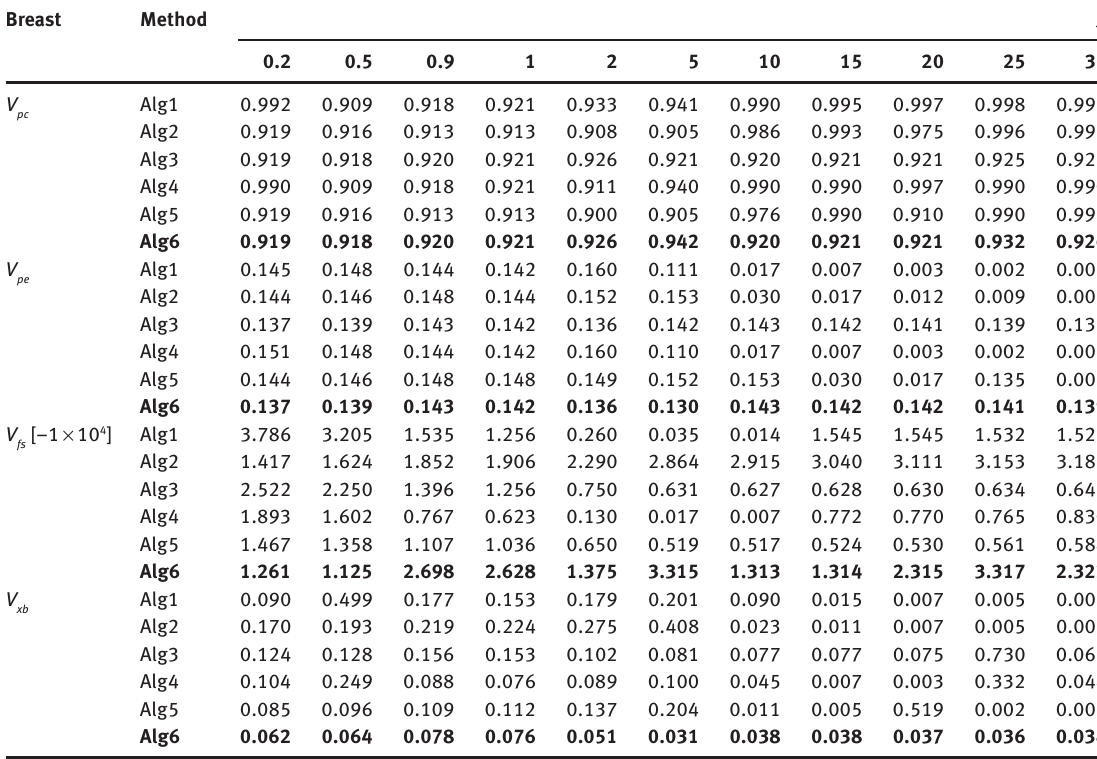
Table 7: Performance Comparison for Breast Images.